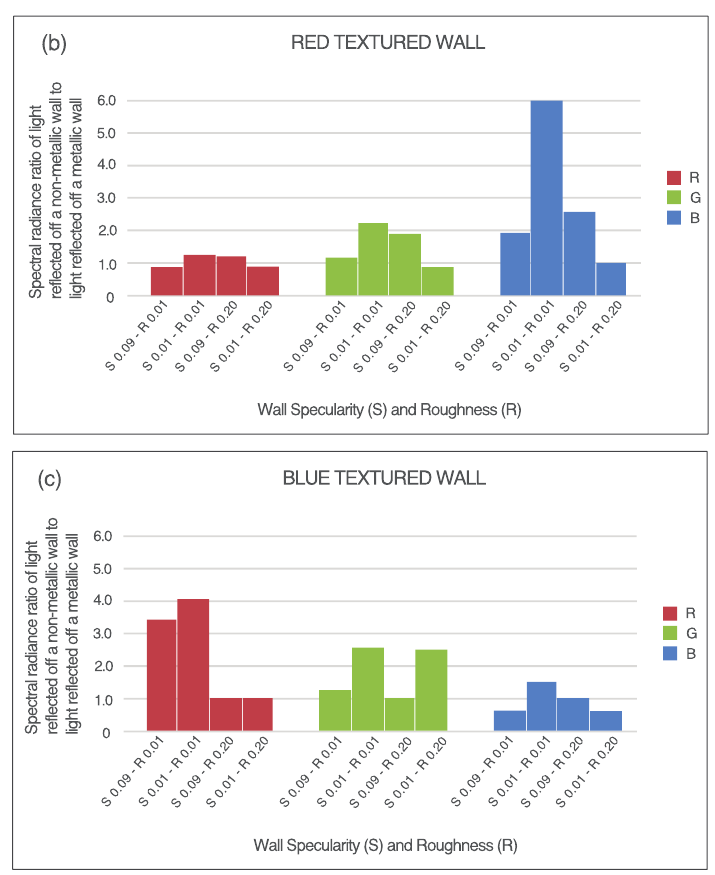
Figure 10. Comparison of spectral radiance ratios of light reflected off an active textured opaque non-metallic wall to light reflected of an active textured metallic wall for those cases with extreme specularity–roughness values.